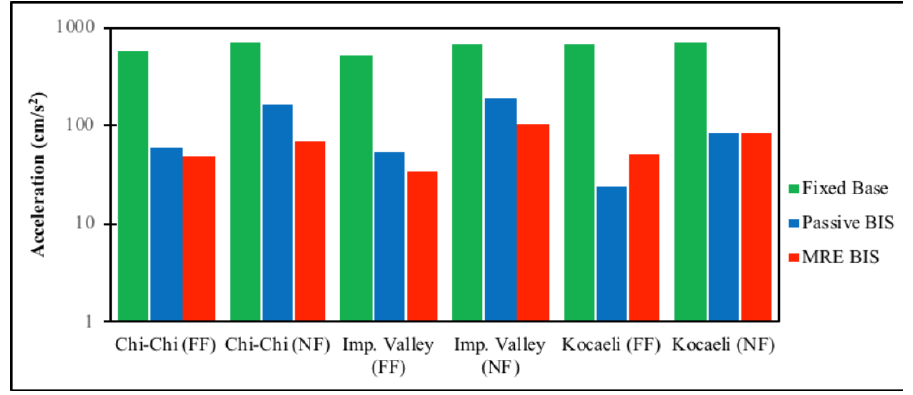
Figure 15. Peak acceleration response at the top storey.